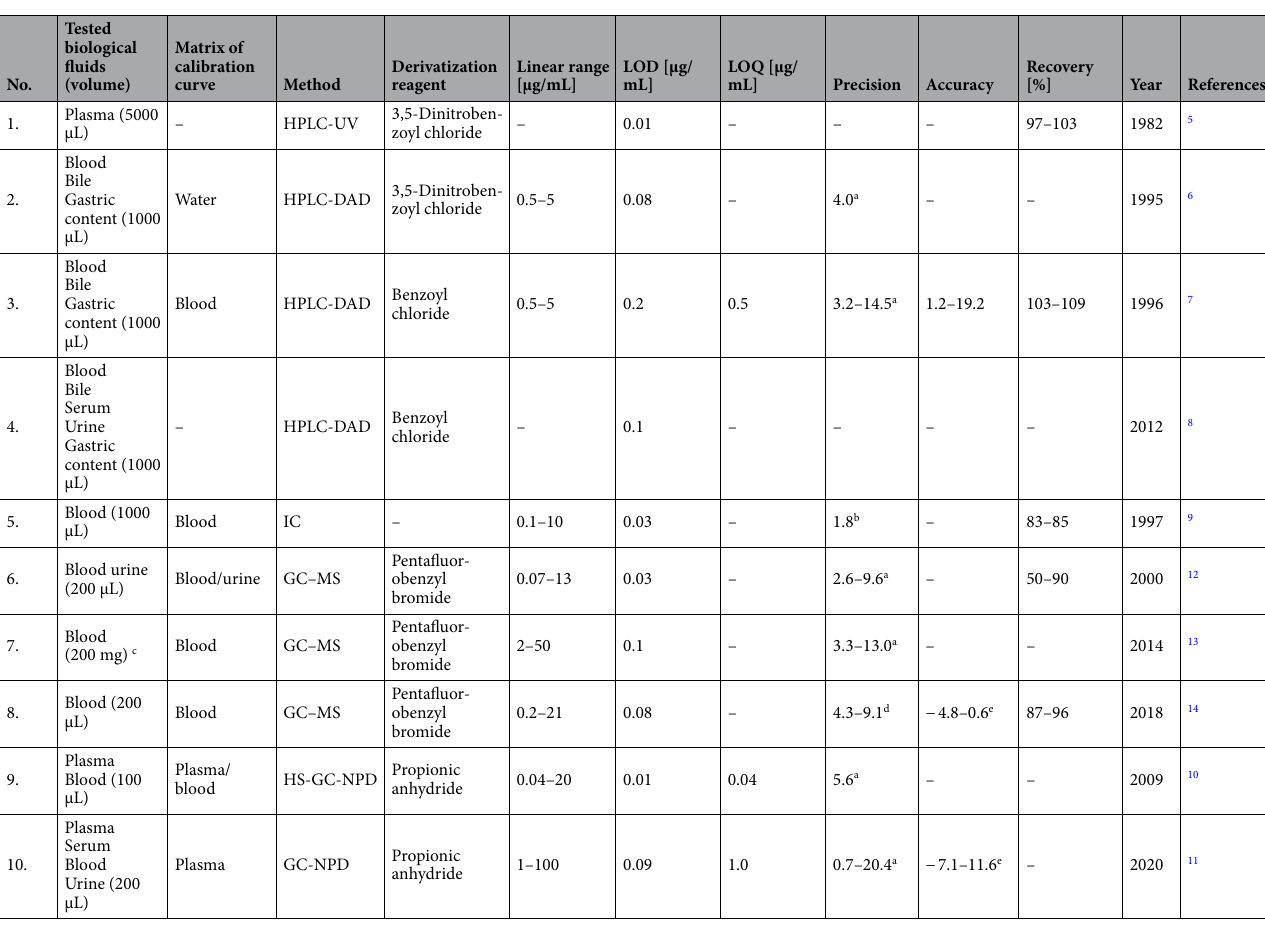
Table 3. Comparison of chromatographic methods for determination of azide in biological samples. LOD limit of detection, LOQ limit of quantification, HPLC-UV high performance liquid chromatography with ultra-visible detection, HPLC-DAD high performance liquid chromatography with diode array detection, IC ion chromatography with conductivity detection, GC–MS gas chromatography coupled with mass spectrometry, GC-NPD gas chromatography with nitrogen phosphorus detection, HS-GC-NPD headspace gas chromatography with nitrogen phosphorus detection, HS-GC-FID/FID headspace gas chromatography with flame ionization detection (dual column/dual detector). Parameters expressed as: a coefficient of variation CV [%]; b standard deviation SD [%]; c weighed of the sample; d relative standard deviation RSD [%]; e relative error RE